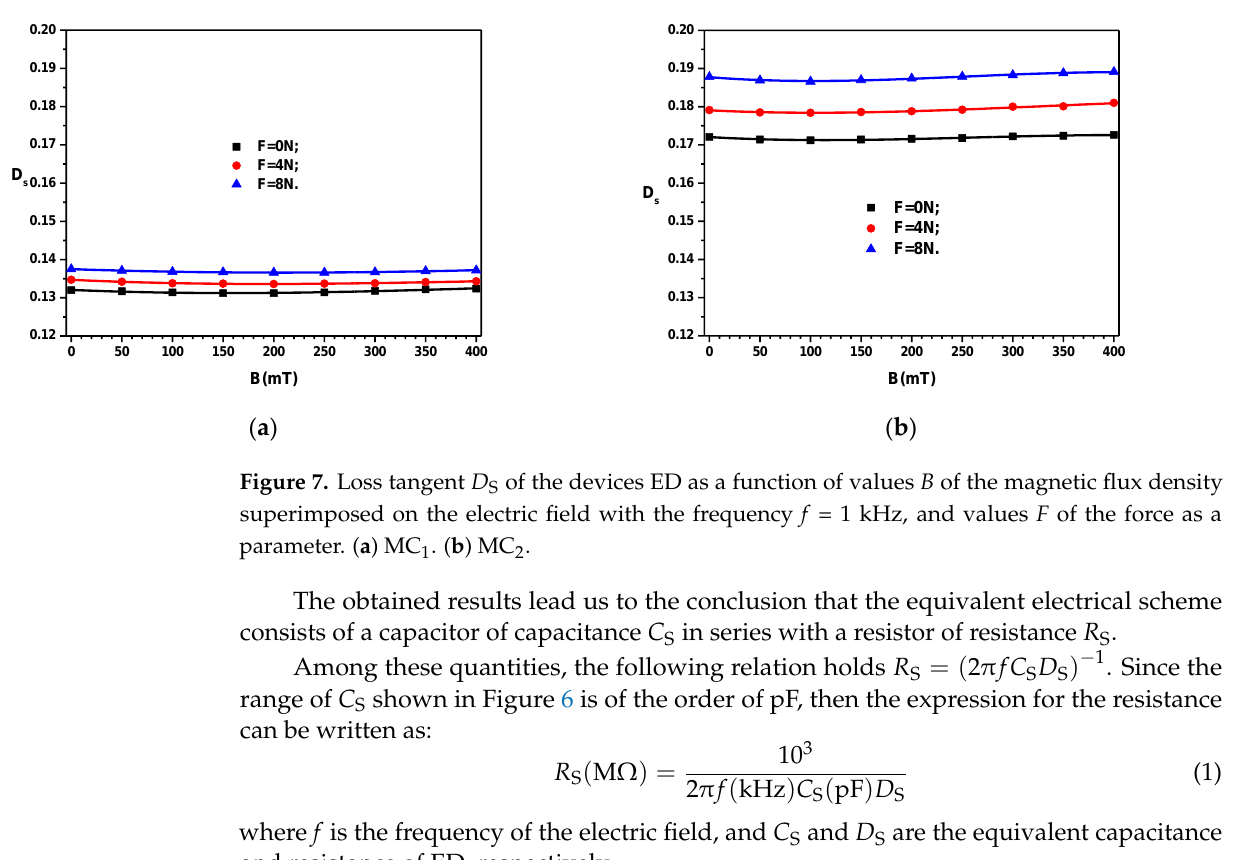
Figure 6. Electrical capacitance Cs of the devices ED as a function of values B of the magnetic flux density superimposed on the electric field with the frequency f = 1 kHz, and values F of the force as a parameter. ( a ) MC 1 . ( b ) MC 2 .